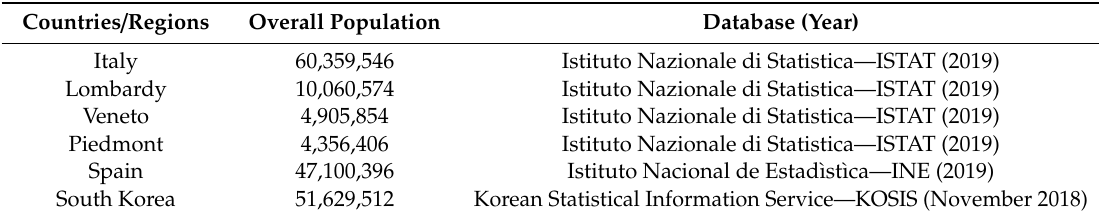
Table 1. Population (approximated) for Italy and Italian regions and for other countries included in the following